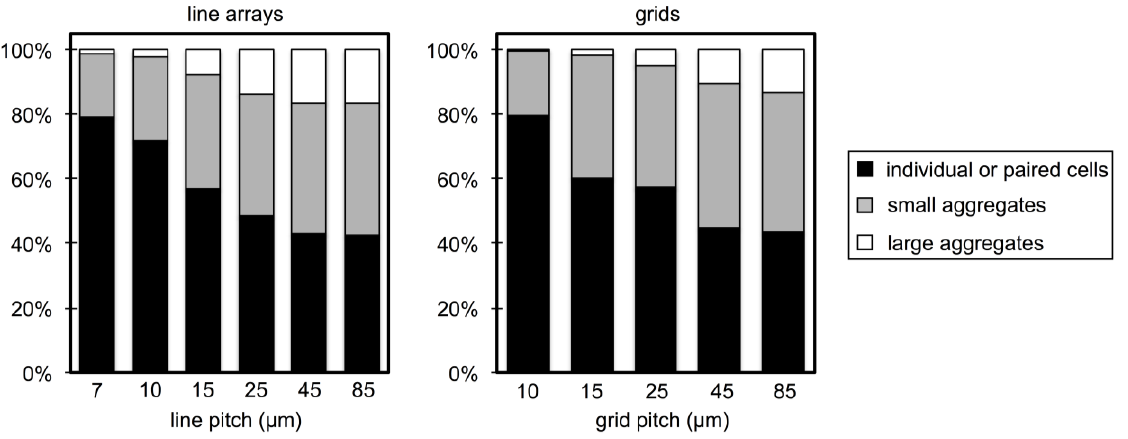
Figure 4. Percentage of microbes existing as individual or paired cells (<20 µm 2 ), small aggregates (20–100 µm 2 ), and large aggregates (>100 µm 2 ) after capture and image analysis for each pitch on PGMA- b -PVDMA line arrays ( left ) and grids ( right